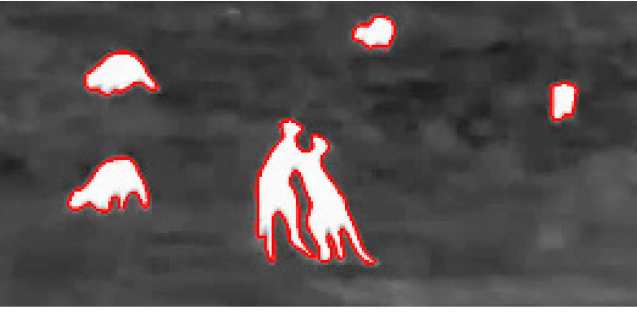
Figure 6. Two kangaroos appear to be one